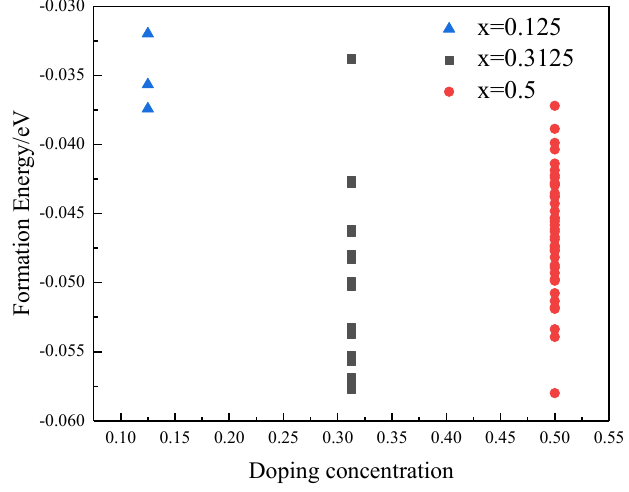
Figure 1. Calculation of E of (Gd 1-x Yb x ) 2 Zr 2 O 7 (x = 0.125, 0.3125, 0.5).